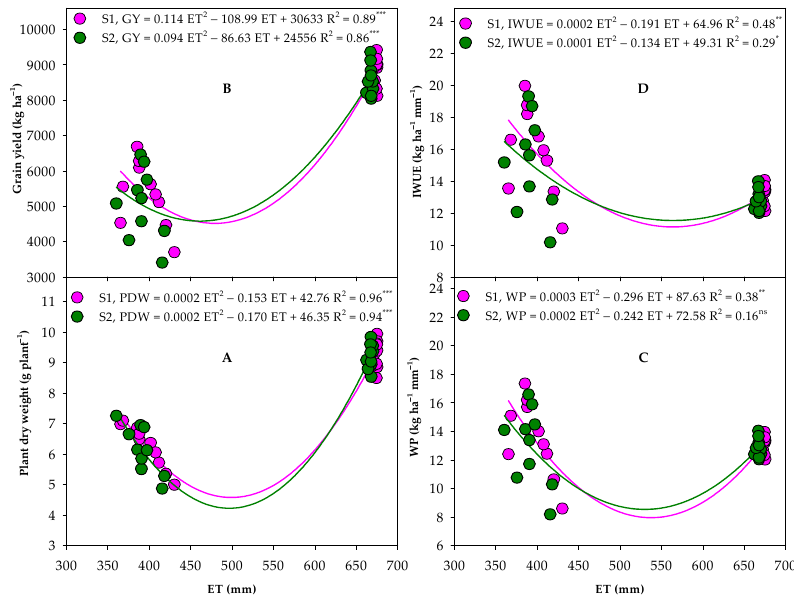
Figure 8. The fit regression models between seasonal evapotranspiration (ET) and plant dry weight ( A ), grain yield ( B ), water productivity (WP, C ), and irrigation water use efficiency (IWUE, D ) in the first season (S1) and second season (S2). *, **, and *** indicate significant at p < 0.05, 0.01, and 0.001, respectively; ns indicates not significant.